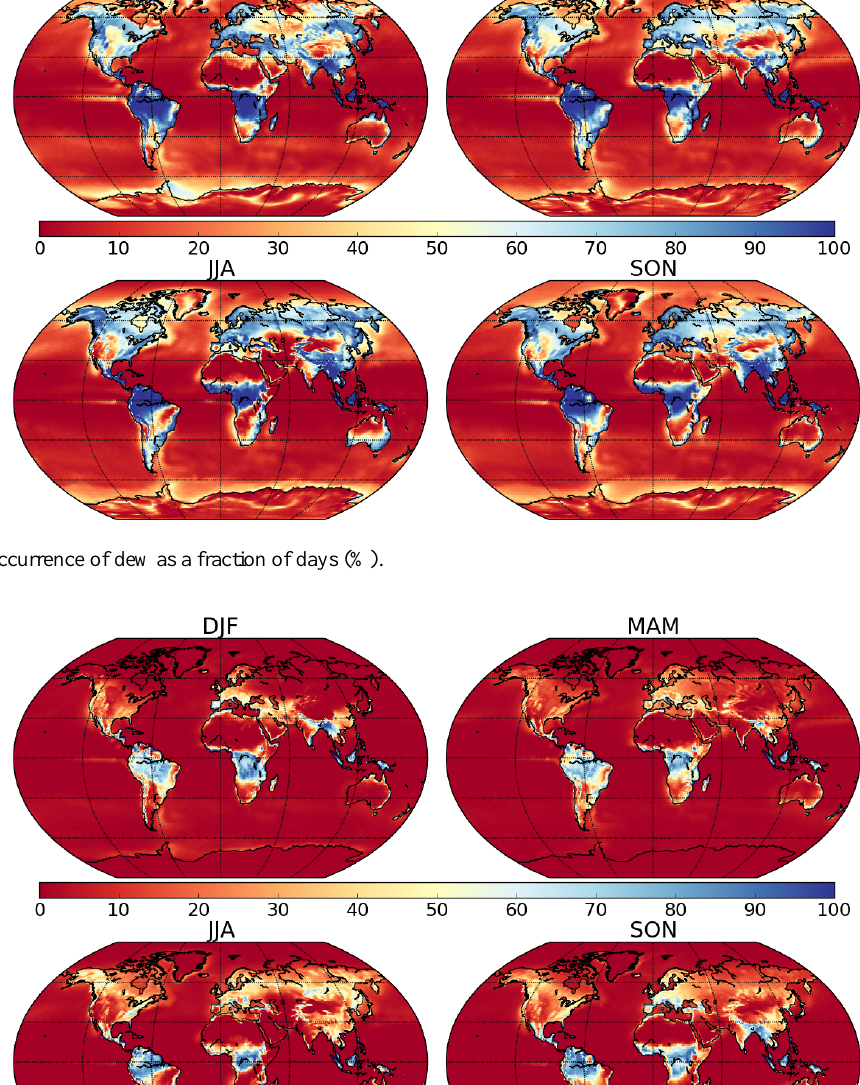
nal cycle in air temperature, denser average cloud cover